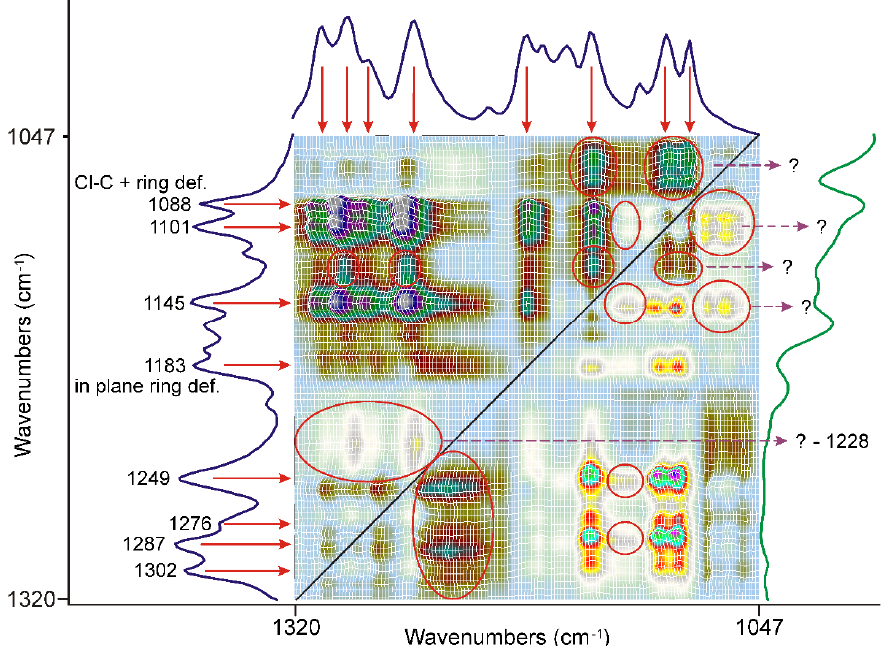
Figure 6. The most significant range on the asynchronous surface is outside the C=O stretching region, characteristic bands of FEN marked with red arrows. Most of the peaks, assigned to the deformation modes of the methyl groups and the C-C-O stretching modes of the ester group, and the etheric oxygen between the aliphatic part of the molecule and the non-chlorine substituted ring, showed a strong correlation to each other. Some peaks, which also had a strong correlation, were assigned to various modes of the aromatic rings, like the Cl-C stretching mode combined with the ring deformation mode at 1088 cm − 1 or the ring in-plane bending mode of the O-substituted ring at 1183 cm − 1 Certain broad features, which cannot be attributed either to FEN or to DIMEB, marked with a red ellipsis, purple dashed arrows and question